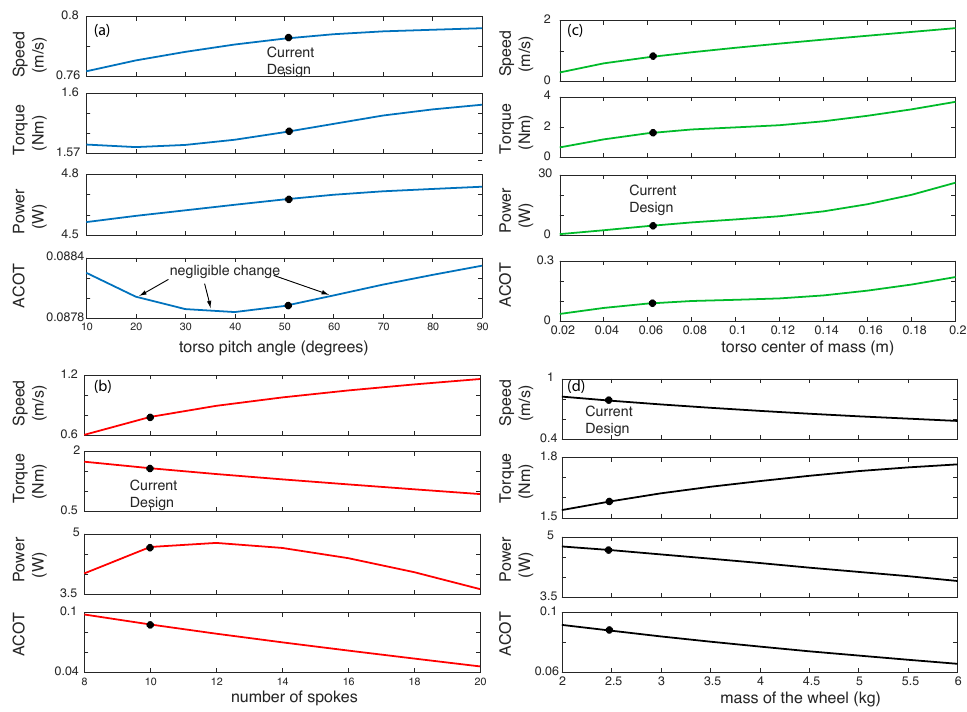
Figure 10. Parameter studies: Effect on speed, torque, power, and COT for motor as a function of ( a ) torso pitch angle, ( b ) number of spokes, ( c ) torso center of mass, and ( d ) mass of the wheel. The current design of the rimless wheel is shown by a